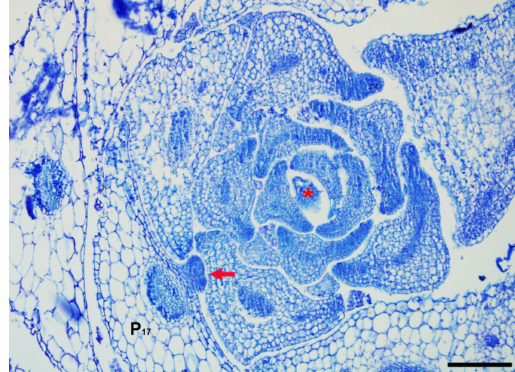
Figure 2. Axillary meristem and shoot apical meristem in Arabidopsis. A bump corresponding to an axillary meristem initiated in a mature leaf axil of P 17 (the seventeenth earliest leaf primordium) is shown. The shoot apical meristem is located in the shoot apex. Arrow indicates axillary meristem and asterisk indicates shoot apical meristem. Bar = 100 µ